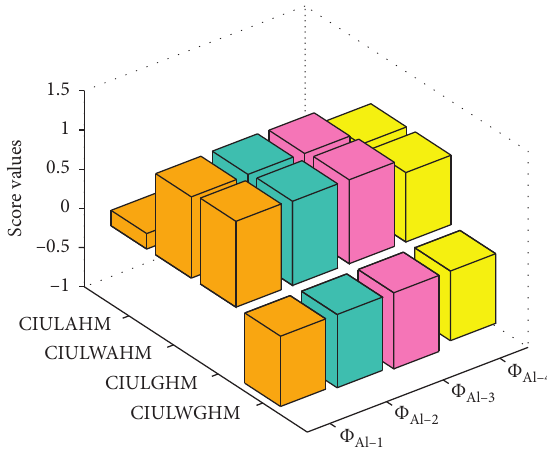
Figure 1: Geometrical expressions of the information given in Table 6. Table 8: Influence of the parameters p